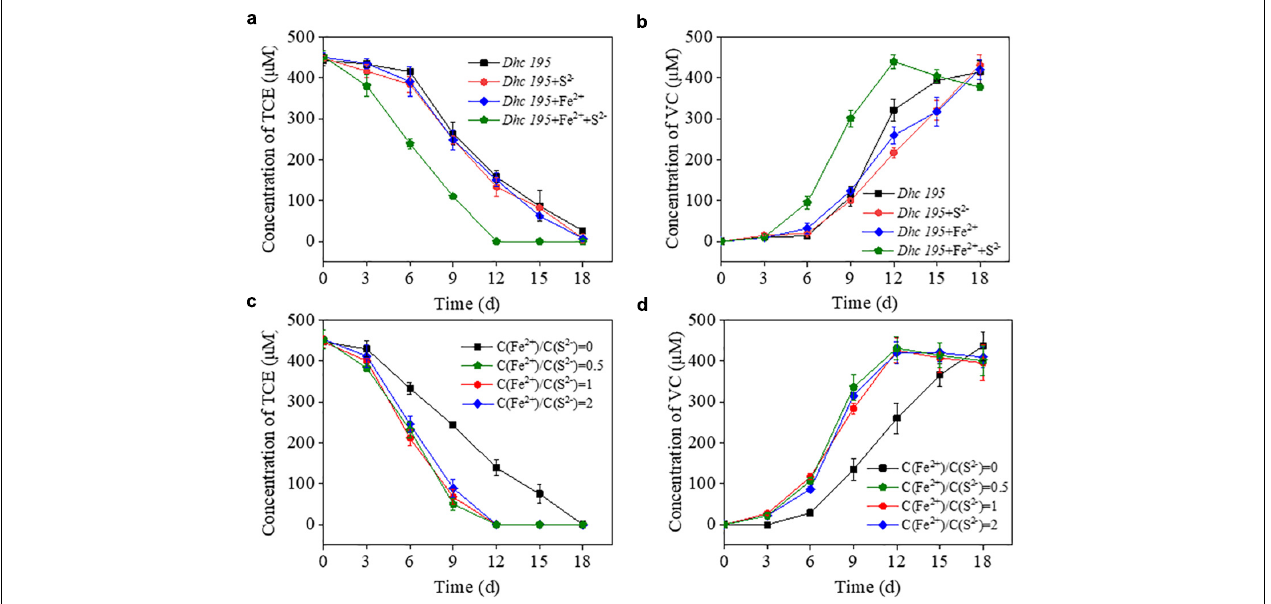
FIGURE 1 | The effects of Fe 2 + or S 2 − on the TCE dechlorination by Dhc 195 (a,b) ; The effects of different concentration ratios of Fe 2 + and S 2 − on the TCE dechlorination by Dhc 195 (c,d) .